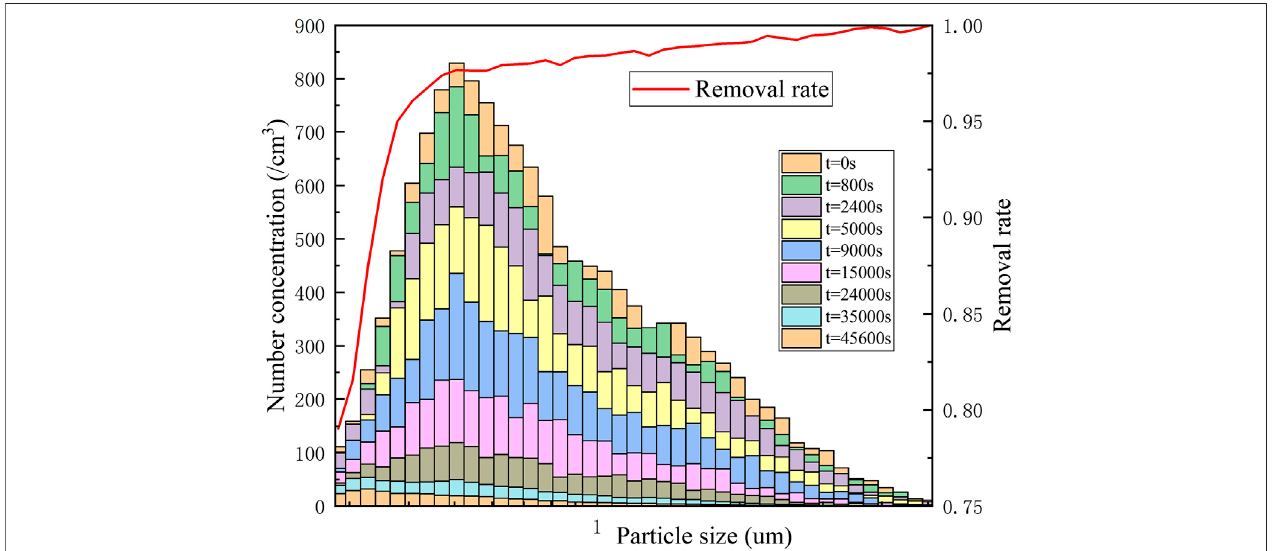
FIGURE 11 | Particle size distribution and removal rate of different particle sizes at different times.